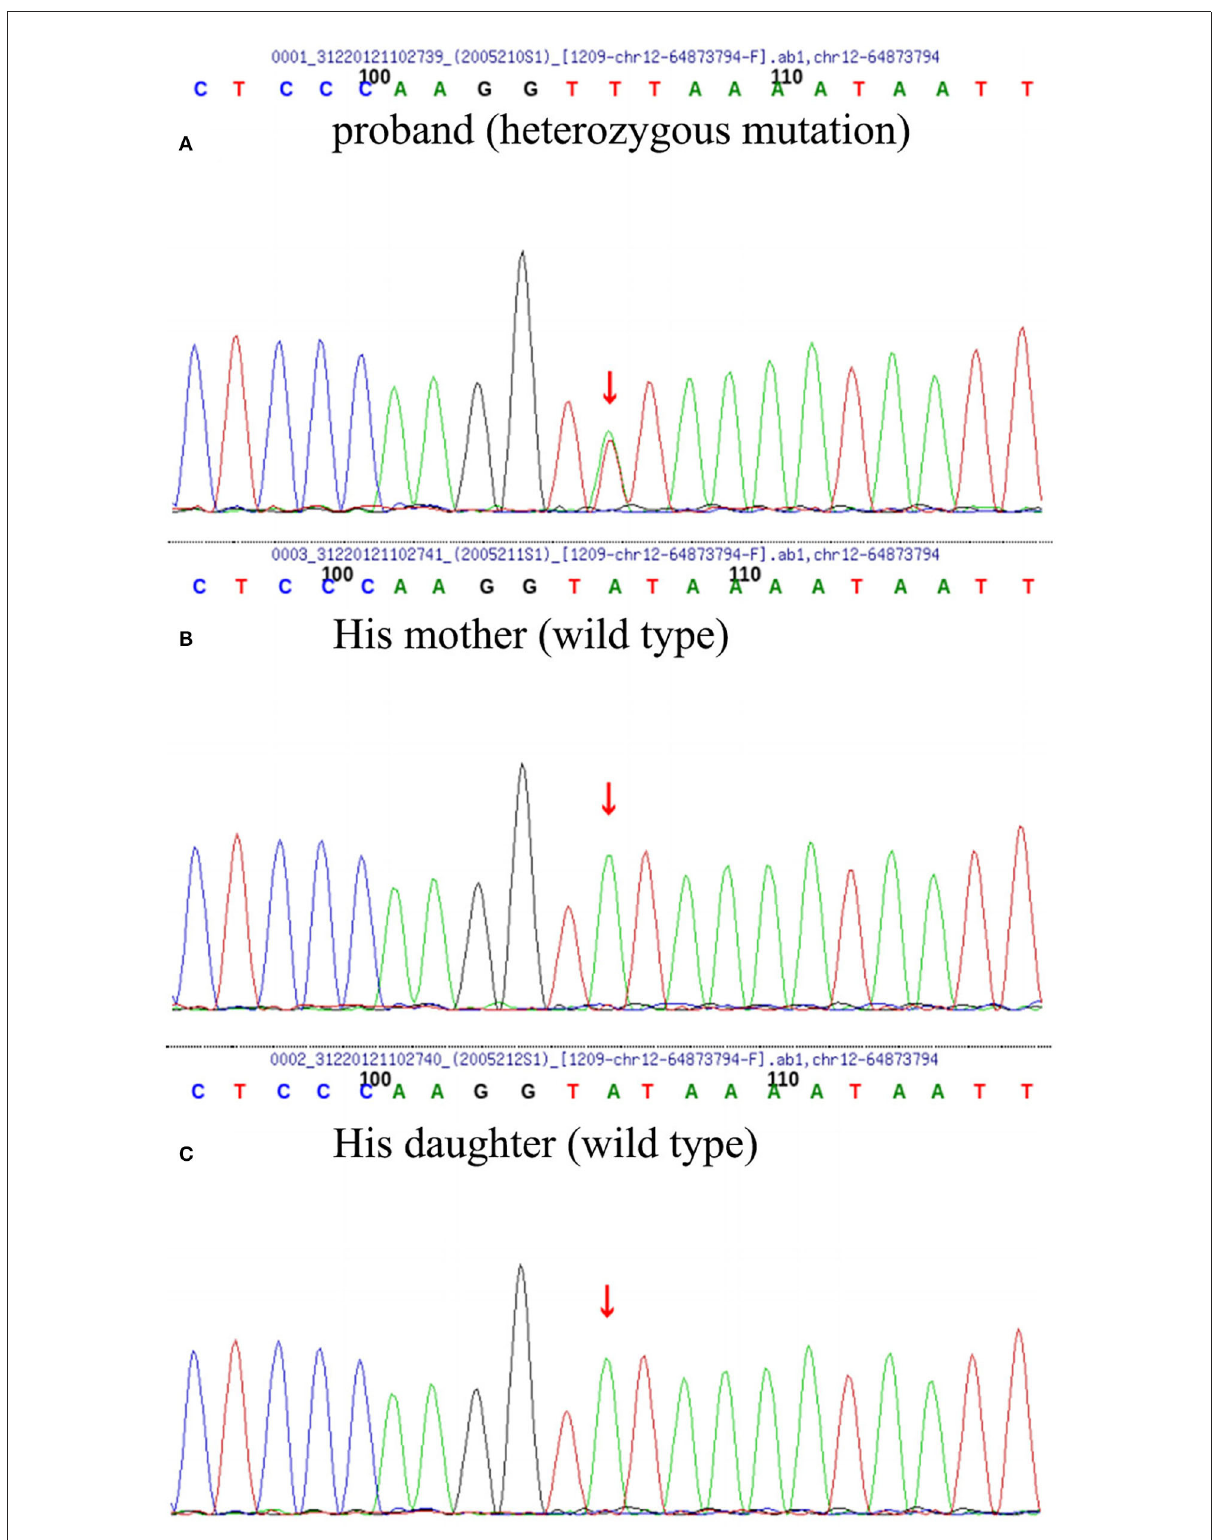
FIGURE3 Whole-genome sequencing (WGS) and repeated primer PCR detection results of the patient (A) , his mother (B) , and daughter (C) the patient carried heterozygous missense mutation of TBK1 c. 704A > T (p. Tyr235phe); however, his daughter and mother were wild